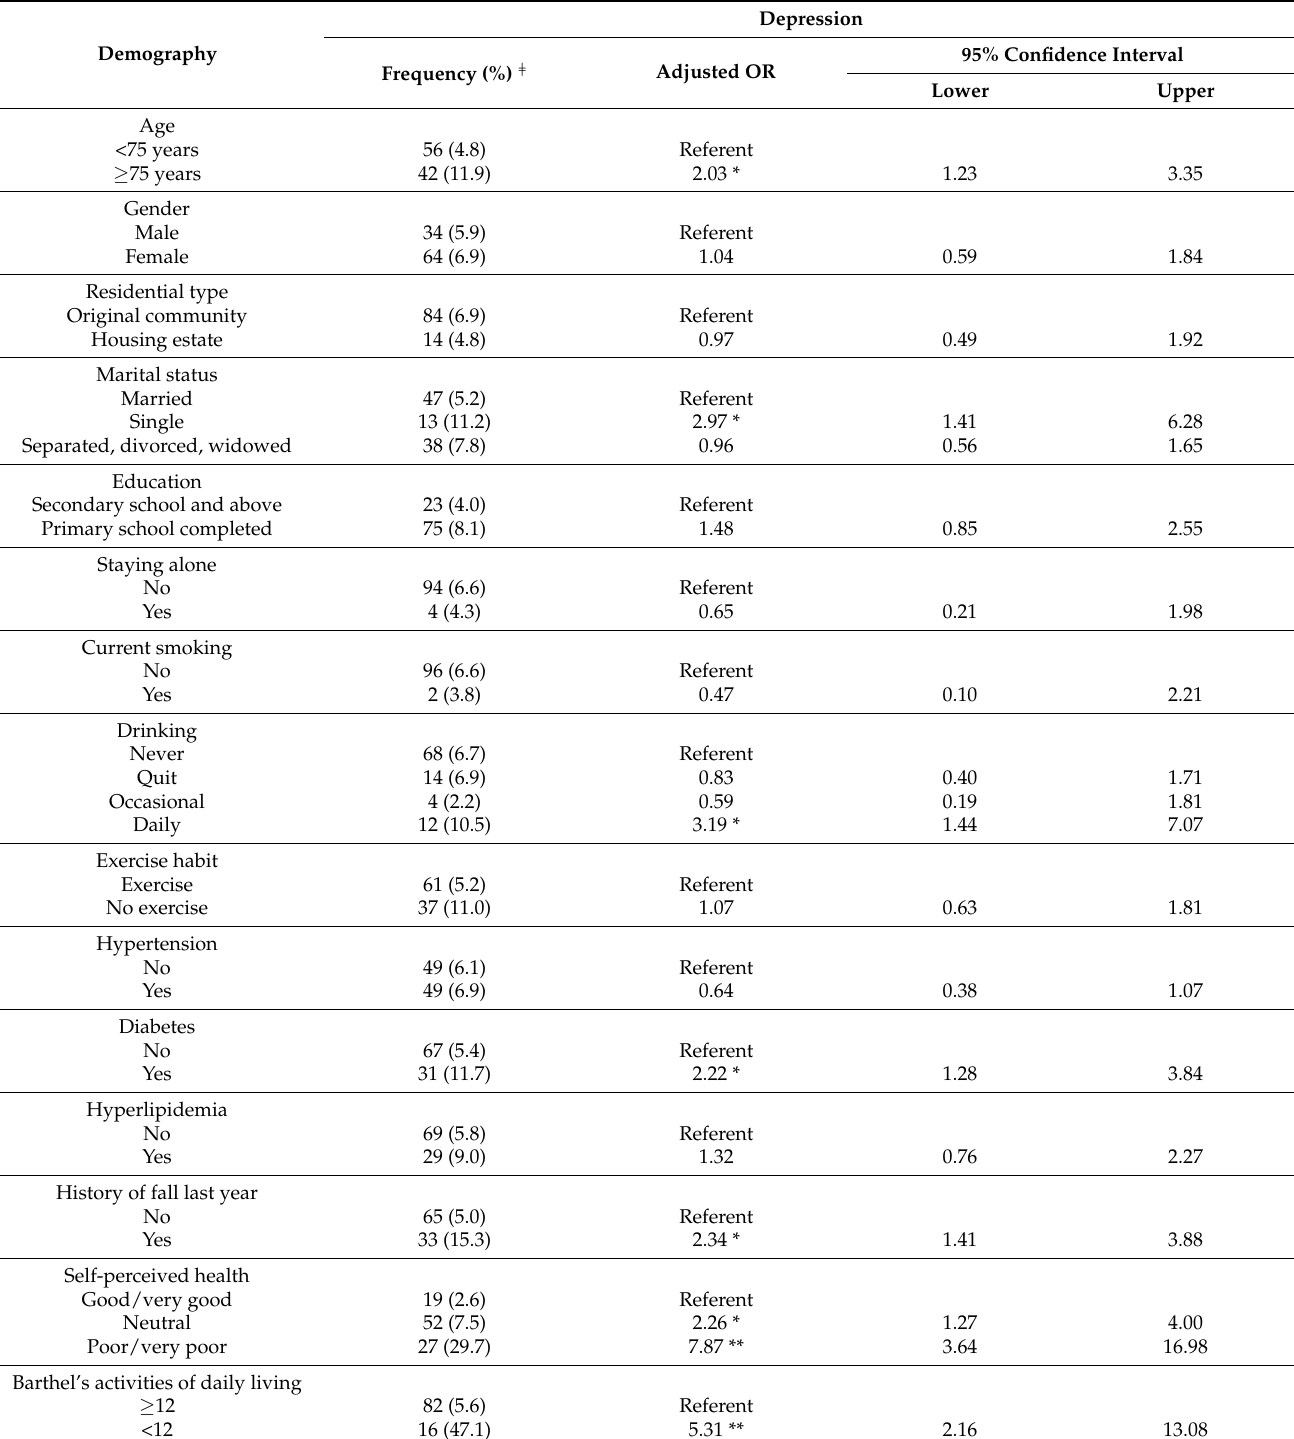
Table 2. Factors associated with depression among study participants, Maehia, Chiang Mai, Thailand ( n =